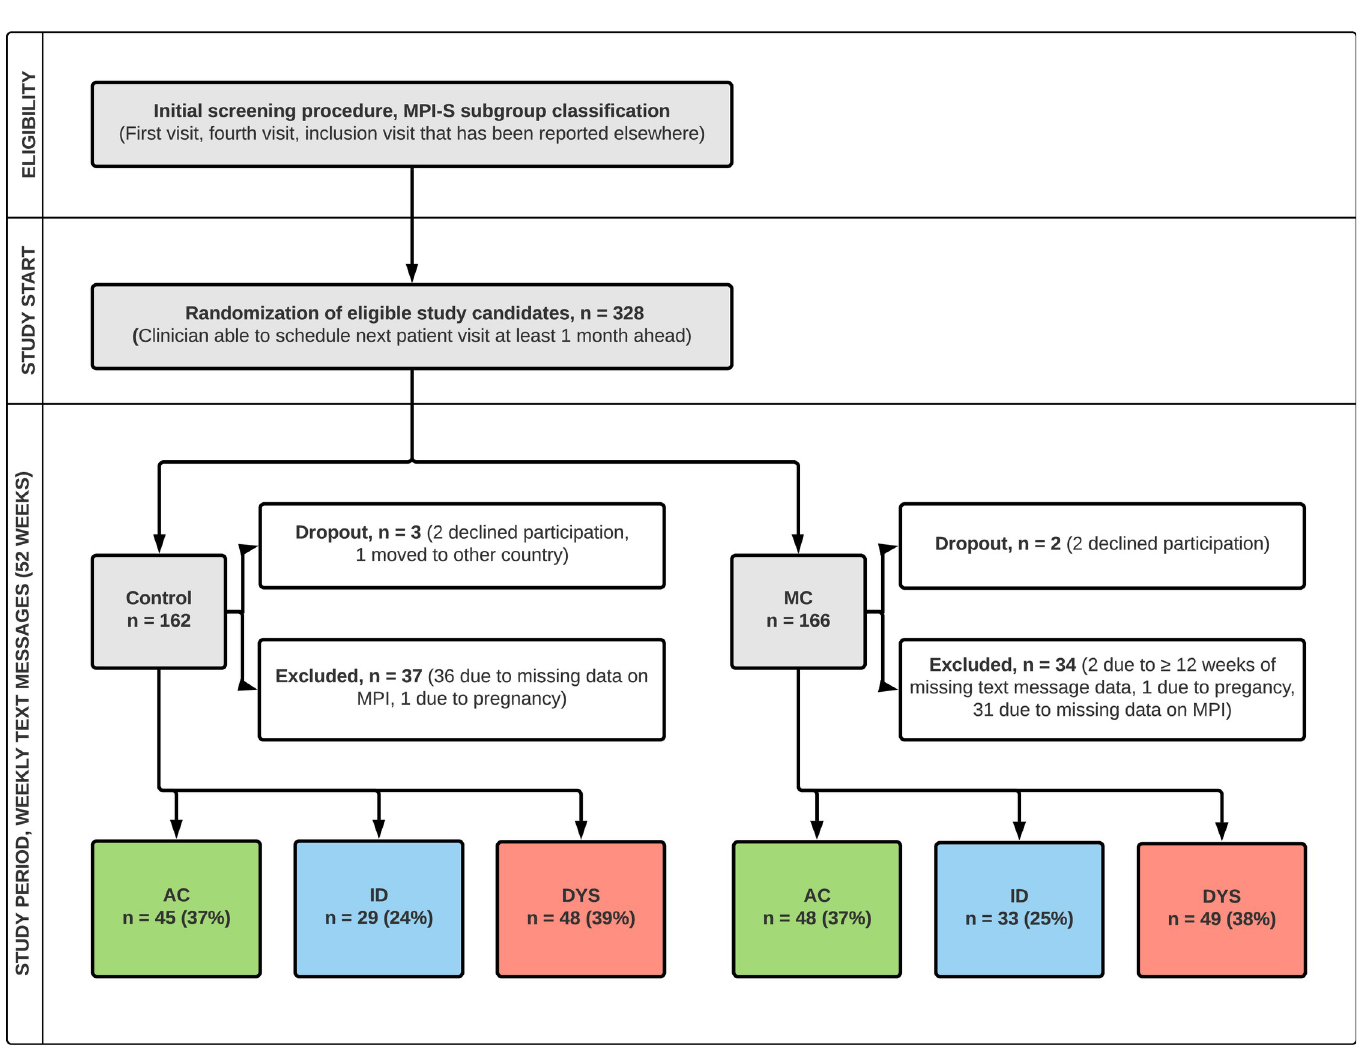
Fig 1. Patient flow. The initial screening procedure has been reported in a previous publication [8]; MPI, West Haven-Yale multidimensional pain inventory; MC , maintenance care; AC , adaptive copers; ID , interpersonally distressed; DYS ,